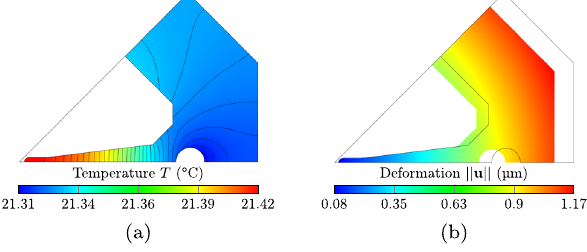
FIG. 30. Temperature T (a) and deformation u (b) in the 2D cavity subject to rf power losses. The distributions are shown for the nominal operating point with 0.1% duty cycle and 21 °C cooling water temperature ( ⋆ in Fig.